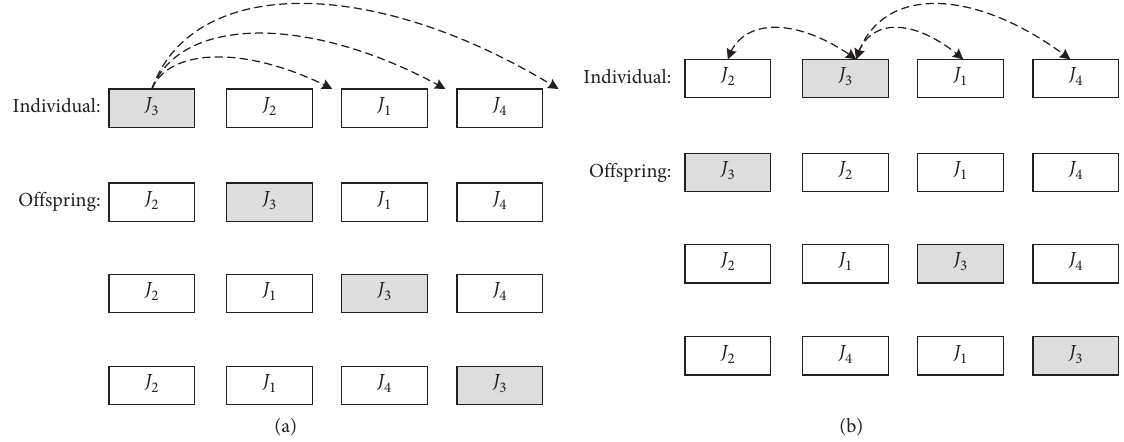
Figure 4: (a) Example of insertion neighbourhood. (b) Example of exchange neighbourhood.